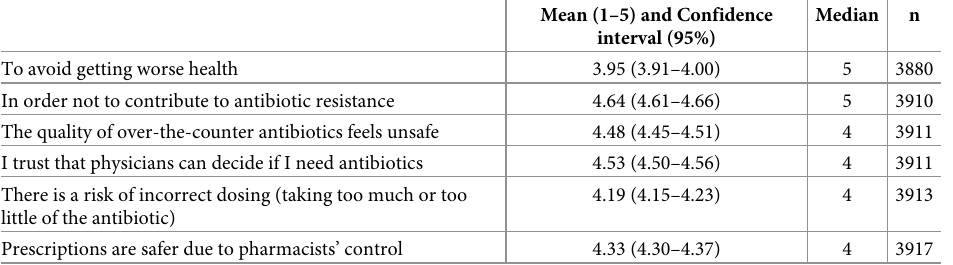
Table 2. Reasons against engaging in non-prescription acquisition of antibiotics (mean, 95% confidence interval, median, and number of respondents).